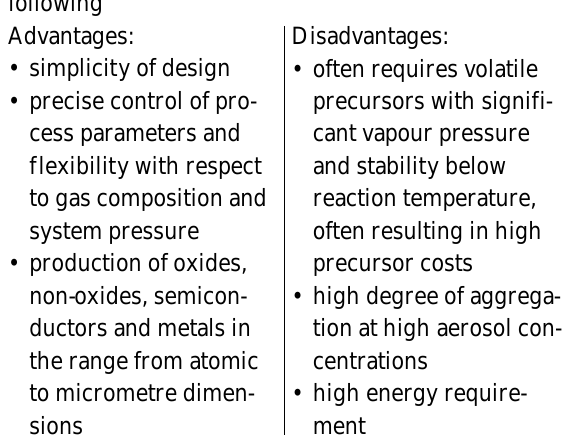
Photograph of the pilot-scale hot-wall reactor operated by the Project House